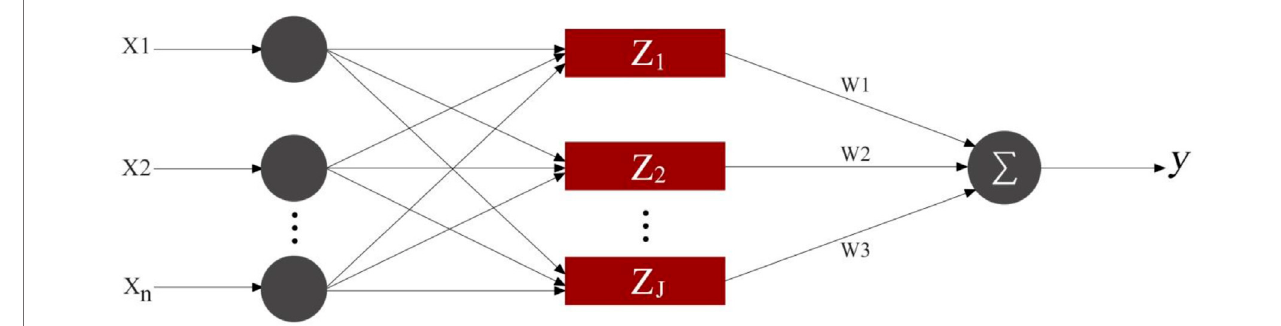
FIGURE 1 | Structure of MLP-ANN (Ramezanizadeh et al., 2019c).